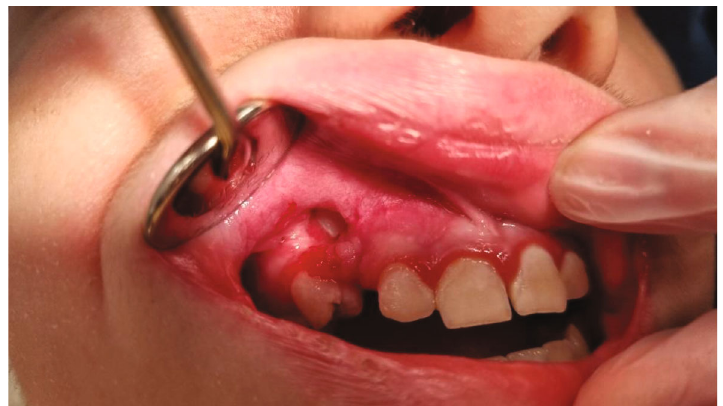
Figure 6: Intraoral view on operative area 2 months after surgery. Tooth 13 has started its